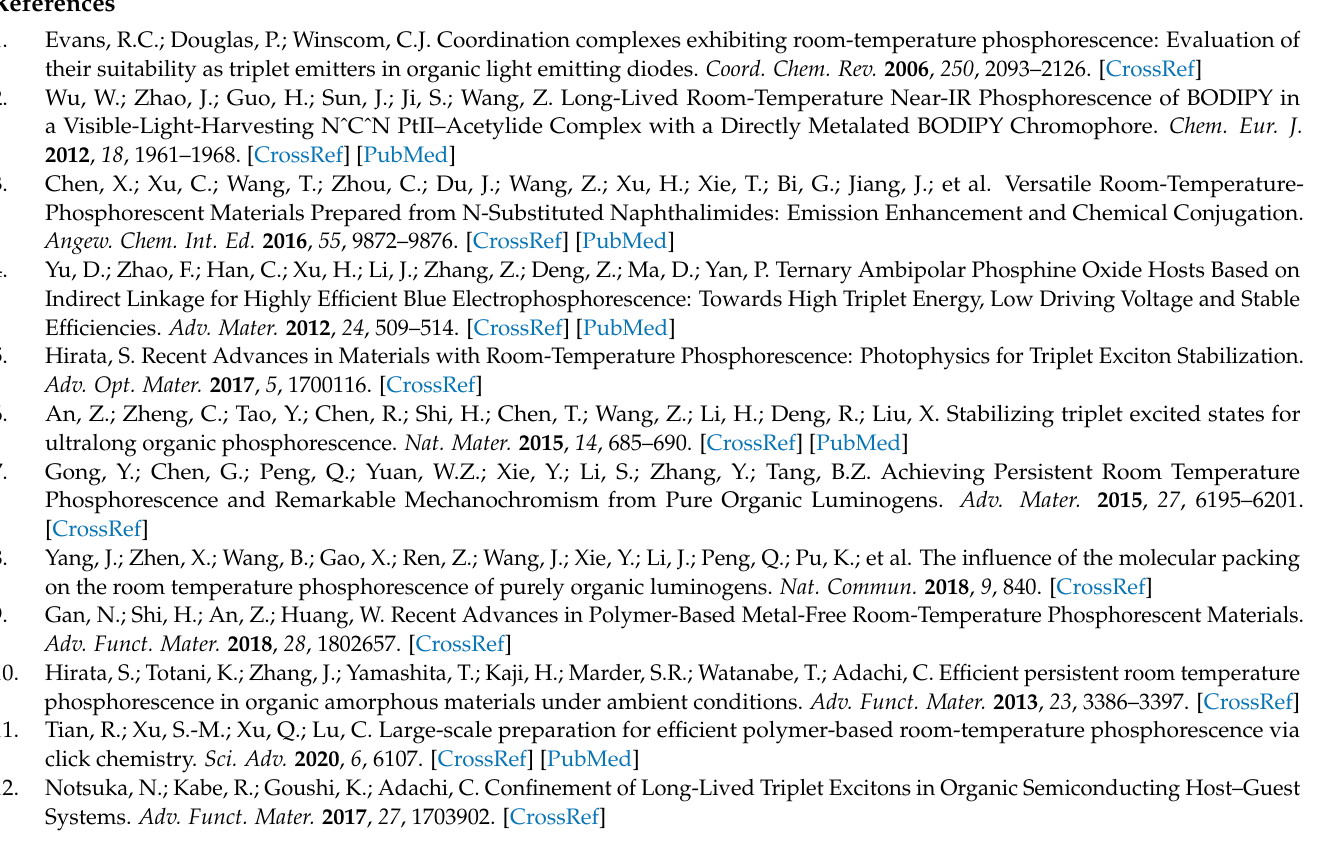
Theoretical calculation results for DBAc-Cz and DPOl-Cz; Figure S1: The Commission Internationale de L’Eclairage (CIE) chromaticity coordinate graph of DBAc-Cz and DTs fluorescence emission; Figure S2: The comparison of steady-state PL spectra (blue line) and phosphorescence spectra (red line) of DTs; Figure S3: PL spectra of DPOl-Cz and the ground mixture of DPOl-Cz and TBD; Figure S4: Fluorescence spectra of DCM solution of DT20, DT100, and DT500 at different density; Figure S5: Luminescence photographs of PVA film doped with DBAc-Cz; Figure S6: 1 H NMR spectrum of DBAc-Cz in DMSO- d 6 ; Figure S7. 1 H NMR spectrum of DPOl-Cz in DMSO- d 6